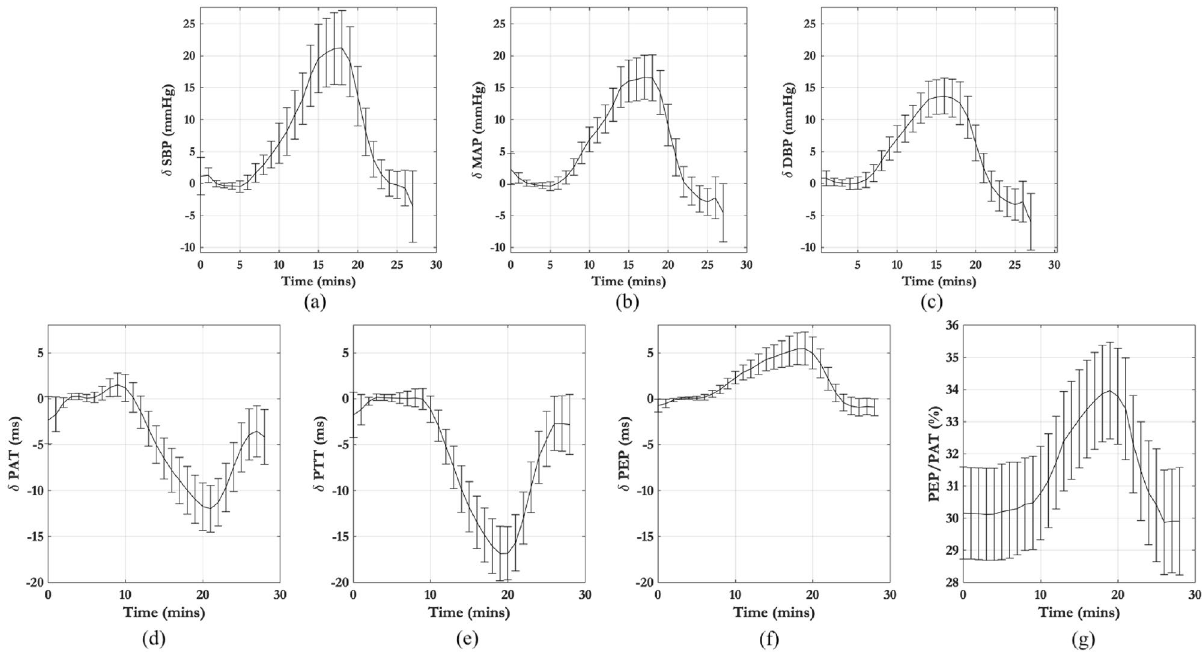
Figure 6. Average deviations from baseline for all participants in the study for ( a ) SBP, ( b ) MAP, ( c ) DBP, ( d ) PAT, ( e ) PTT and ( f ) PEP. ( g ) variations in PEP as a percentage of PAT from the start to the end of the study. The error bars show the 95% confidence intervals.